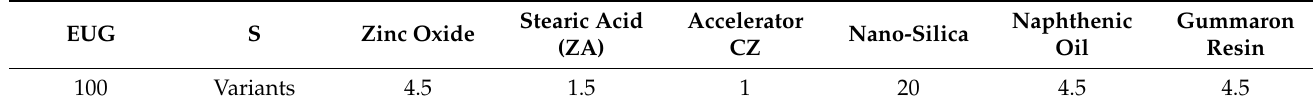
Table 3. Basic formula of SEUG.